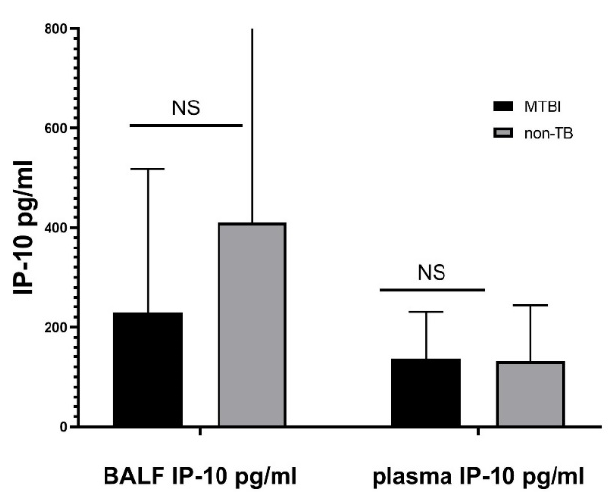
Figure 1. IP-10 responses in BALF and plasma in Mycobacterium tuberculosis infected subjects and